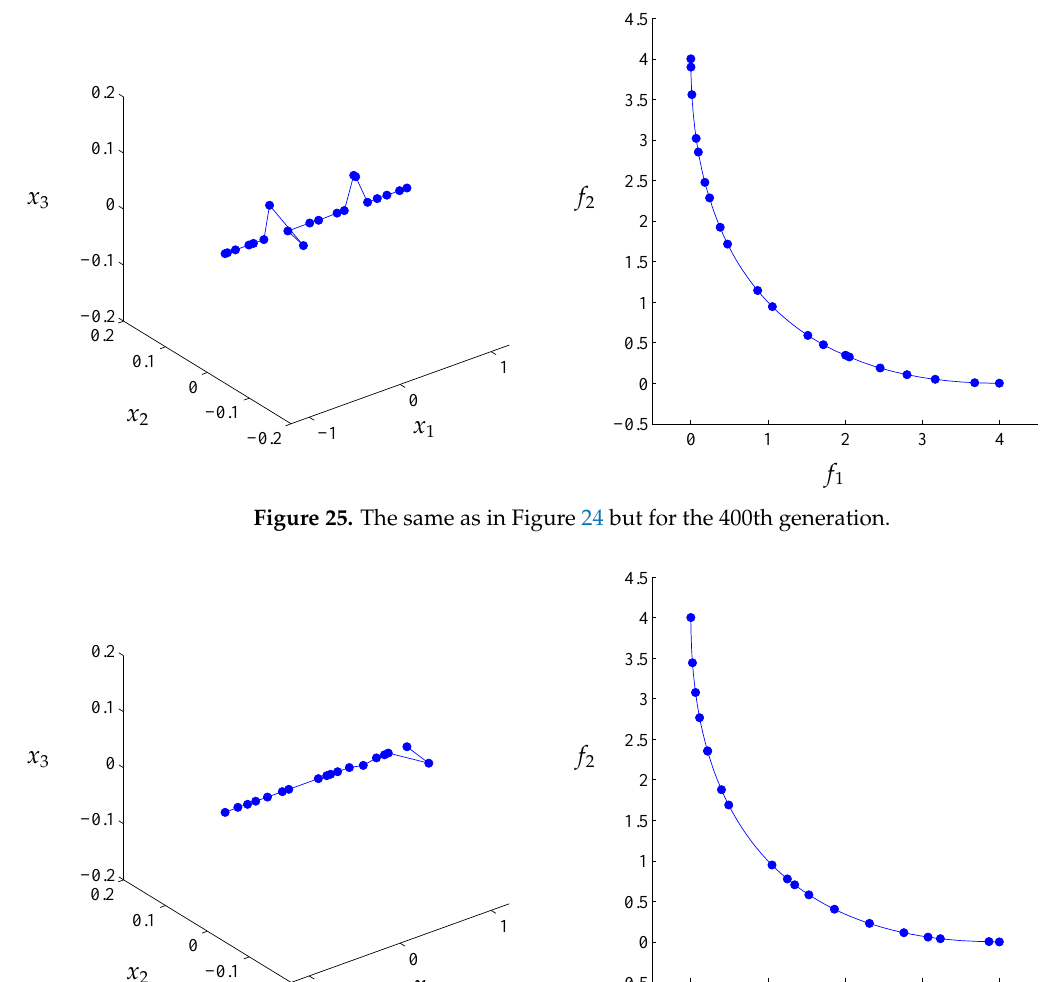
Figure 24. ( Left ) The blue dots and the blue polygon line are the discrete and continuous approximation, respectively, for the Pareto set of MOP (Equation (17)) in the 300th generation. ( Right ) respective sets F ( A ) and F ( B ) of the Pareto front.